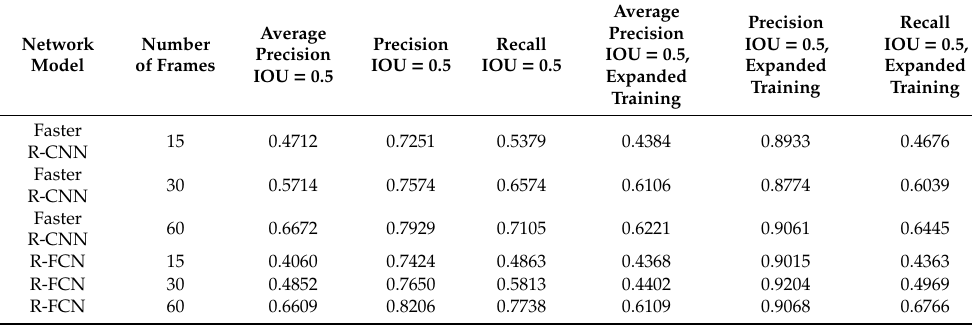
Table 3. Summary of the results of the in-depth analysis including the calculated parameters of average precision, precision, and recall for the networks Faster R-CNN and R-FCN (15, 30, and 60